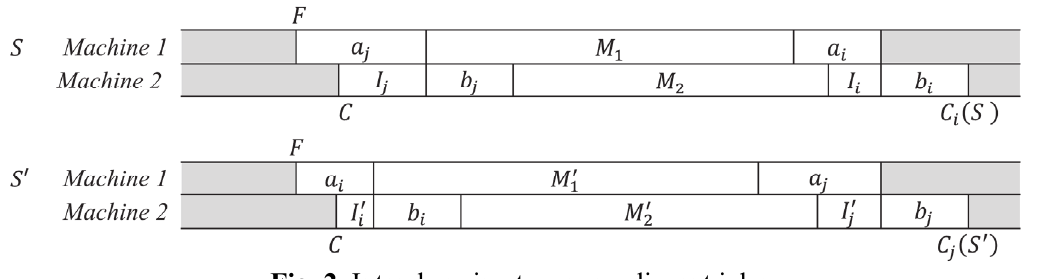
Fig. 2. Interchanging two non-adjacent